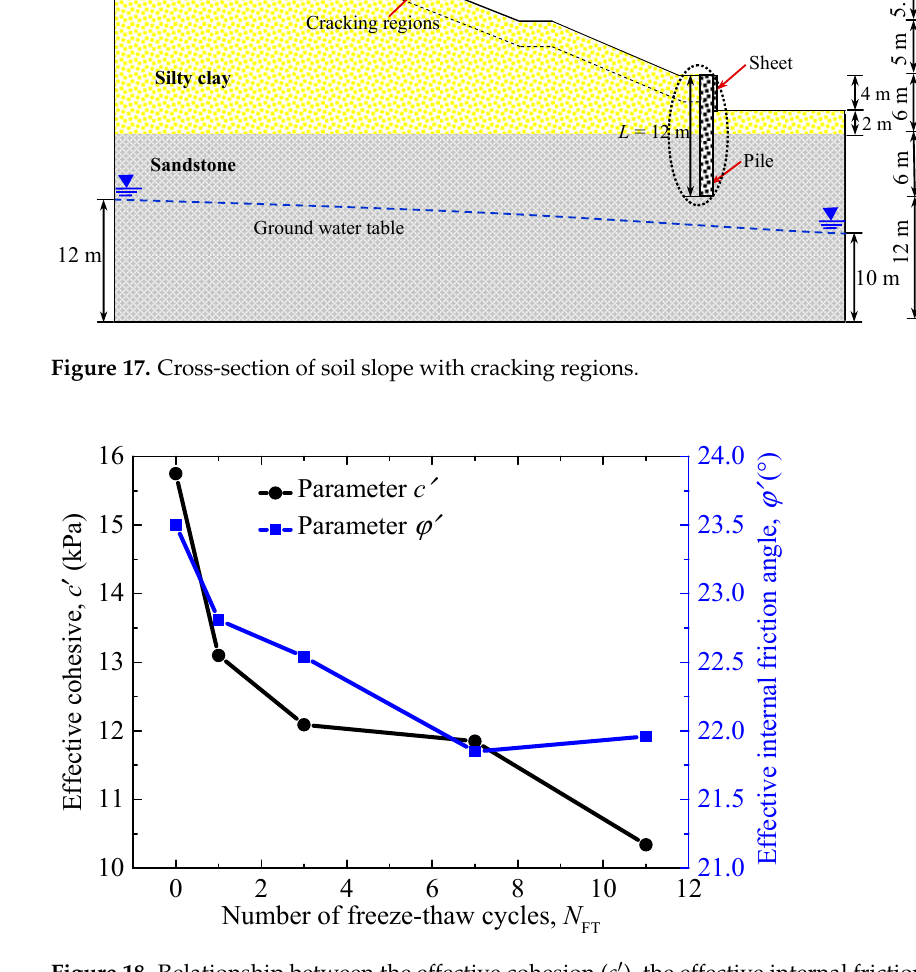
Figure 18. Relationship between the effective cohesion ( c ′ ), the effective internal friction angle ( φ ′ ), and the number of freeze-thaw cycles ( N FT ). The values of S r and PWP observed along lines L1 and L2 are plotted in Figure 19 with respect to N FT . The results indicate that S r and PWP increase significantly with increasing N FT . The values of S r observed at the top and slope toe at the eleventh F-T cycle are about 23.7% and 17.4% greater than the corresponding values observed in the initial state. Clearly, N FT has a significant effect on fluctuations in the water content, which influences the stability of the cutting slope, as demonstrated by the plot of the FOS with respect to N FT in Figure 20. Compared to the FOS under d s and ∆ T , a lower FOS was observed under the effect of F-T cycle. In addition, Figure 19c,d demonstrate that S r and PWP are significantly increased within the dotted box region of the figures. Such behavior may be due to the application of an I r value that is close to the value of k s for the silty clay layer, which would induce runoff along the slope surface.